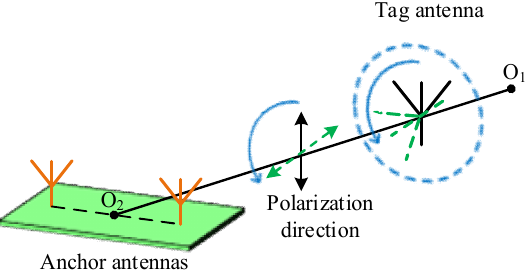
Figure 3. Scenario 2: Tag antenna rotates around its boresight (O 1 O 2 ).